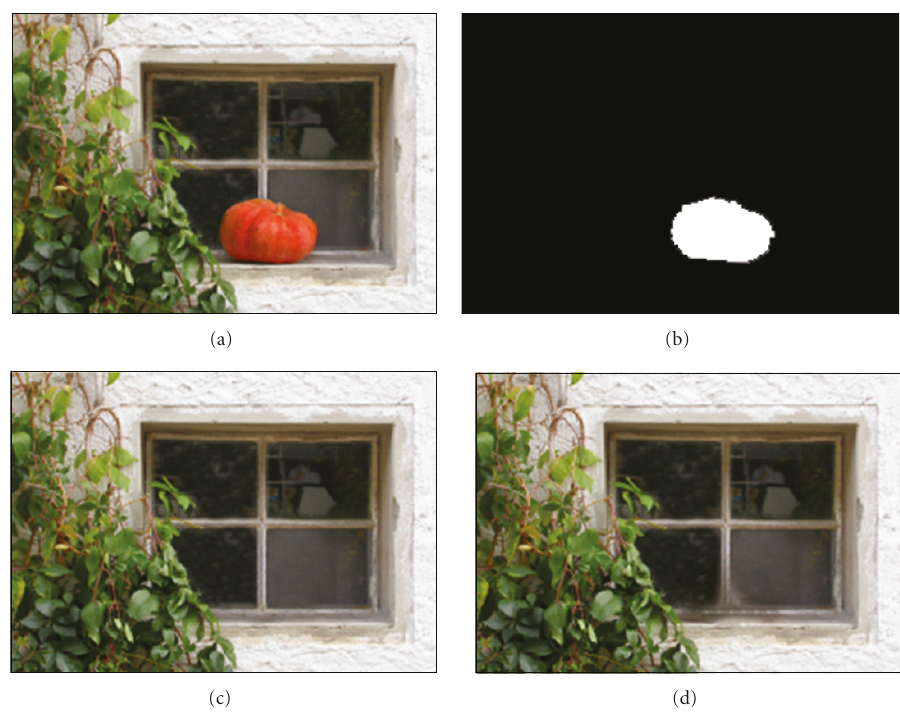
Figure 12: A given image for object removal (a), the mask image (b), the method in [8] (c), and the proposed method (d).